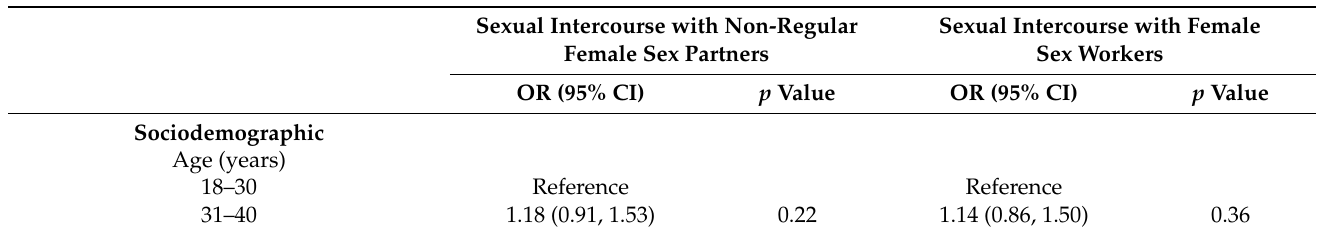
Table 3. Associations between background characteristics and sexual intercourse with non-regular female sex partners and female sex workers in the past 6 months ( n =